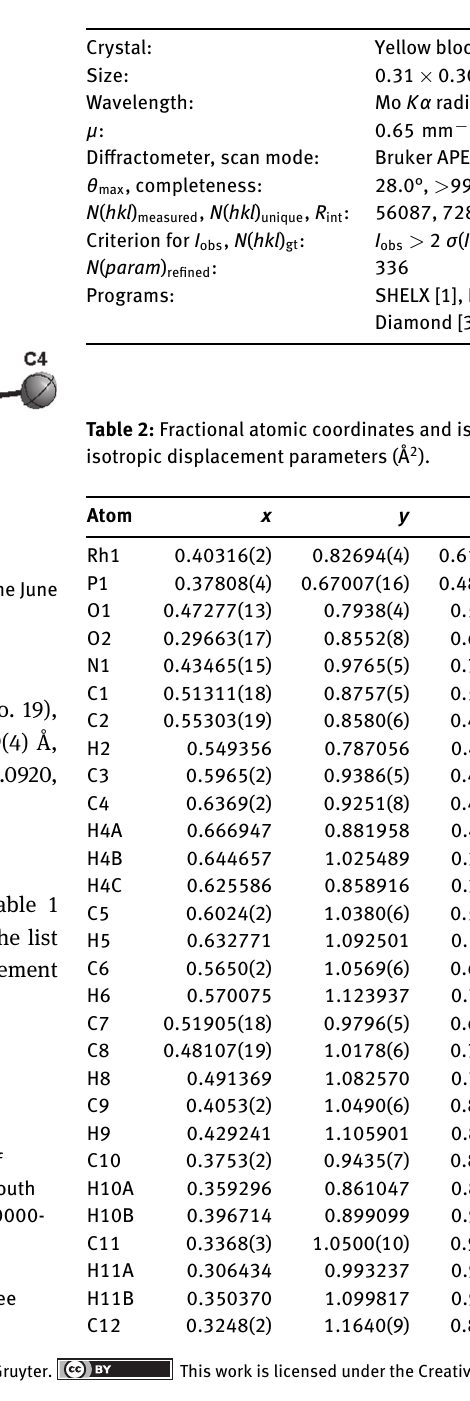
Table 1: Data collection and handling.